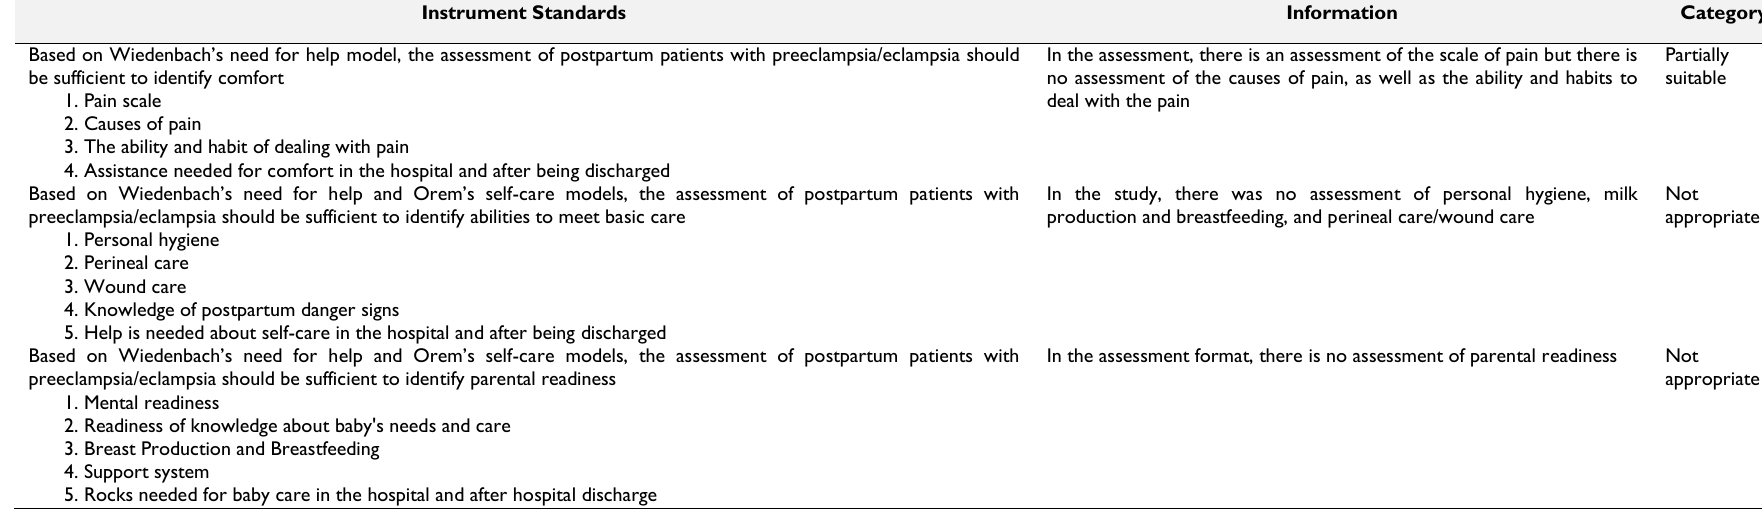
Instrument Standards Information Category